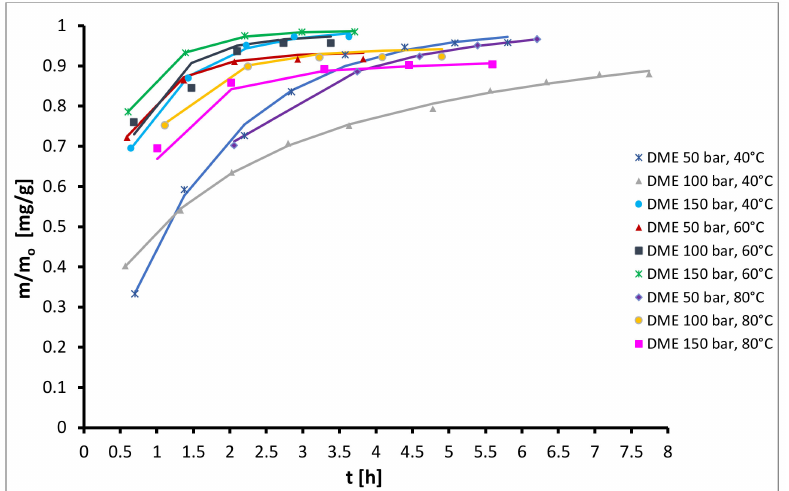
Figure 7. Experimental (symbols) and modelled (lines) kinetic curves for extraction with DME as